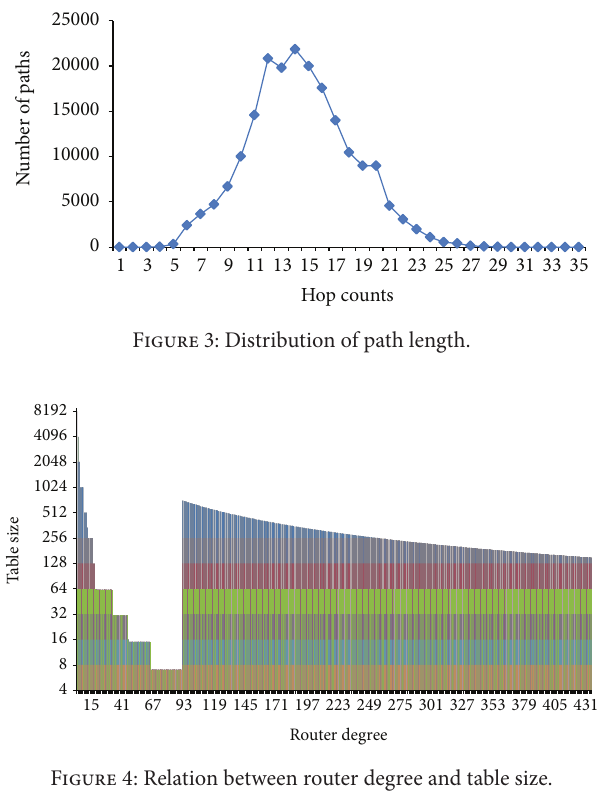
Figure 4: Relation between router degree and table size.